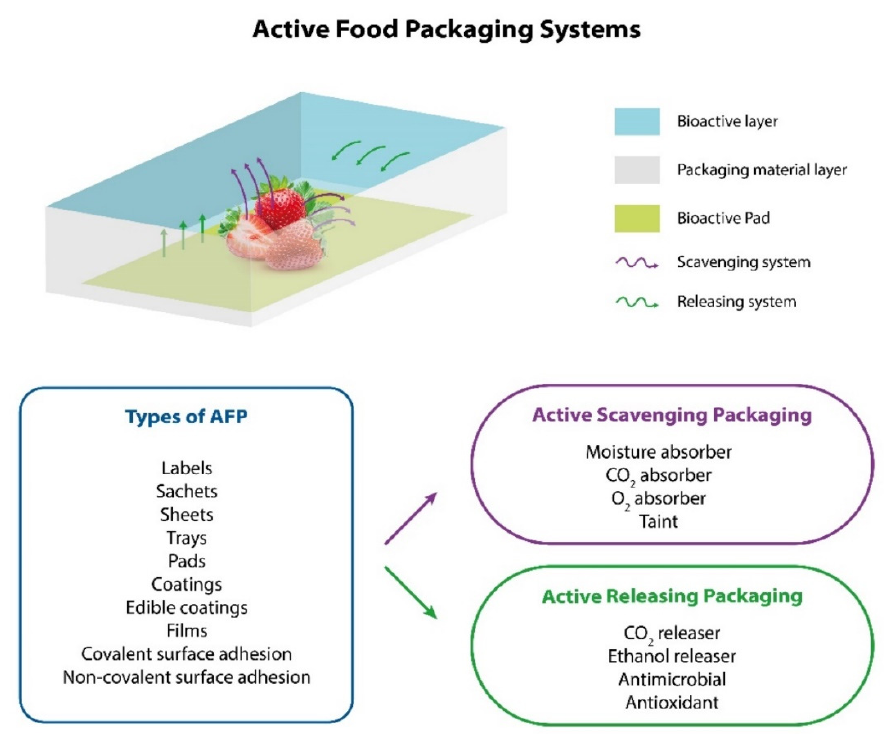
Figure 1. Schematization of the active food packaging (AFP) systems and their main features.